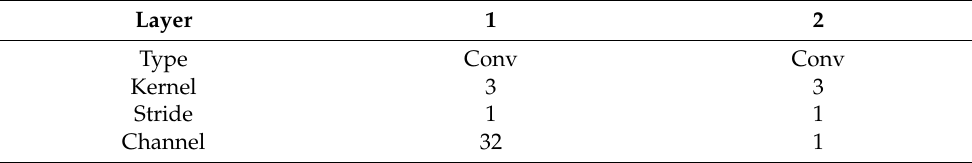
Table 1. Feature integration